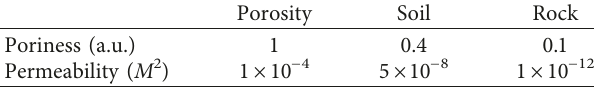
Table 3: A-1 to A-5 samples parameters. Sample